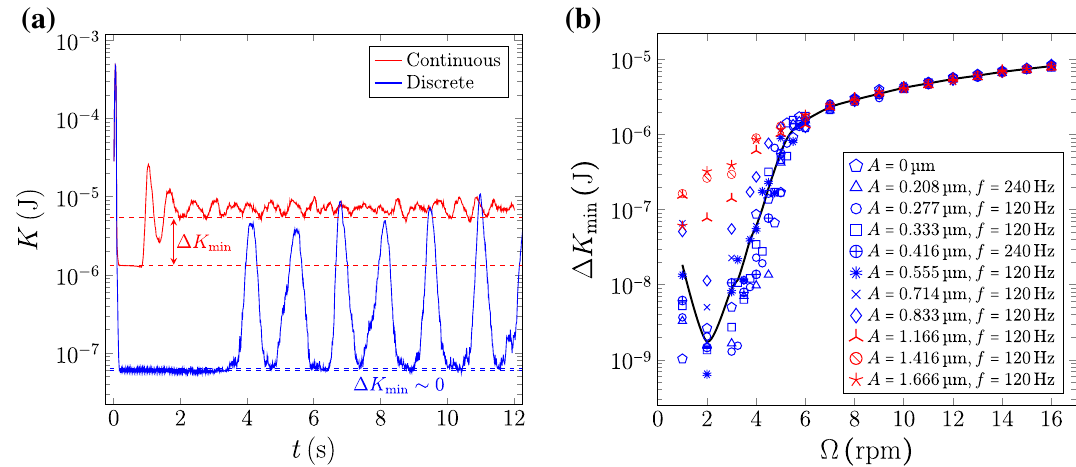
Figure 2. ( a ) Total kinetic energy of the system for both discrete and continuous cases. The discrete regime corresponds to A = 0.8 µ m and (cid:31) = 2 rpm , whereas the continuous regime corresponds to A = 0.8 µ m and (cid:31) = 10 rpm . ( b ) (cid:31) K min for different forcing amplitudes and frequencies. It is observed that, depending on the forcing amplitude, there are two distinguishable data sets. (cid:31) K min is very similar for low amplitudes, whereas it jumps for amplitudes larger than A ≈ 1 µ m . The increment of (cid:31) K min at the smallest value of (cid:31) is just apparent; it is the energy of just one particle falling a distance of one diameter. The continuous black curve corresponds to a smoothing spline of all the collapsing data (blue data).